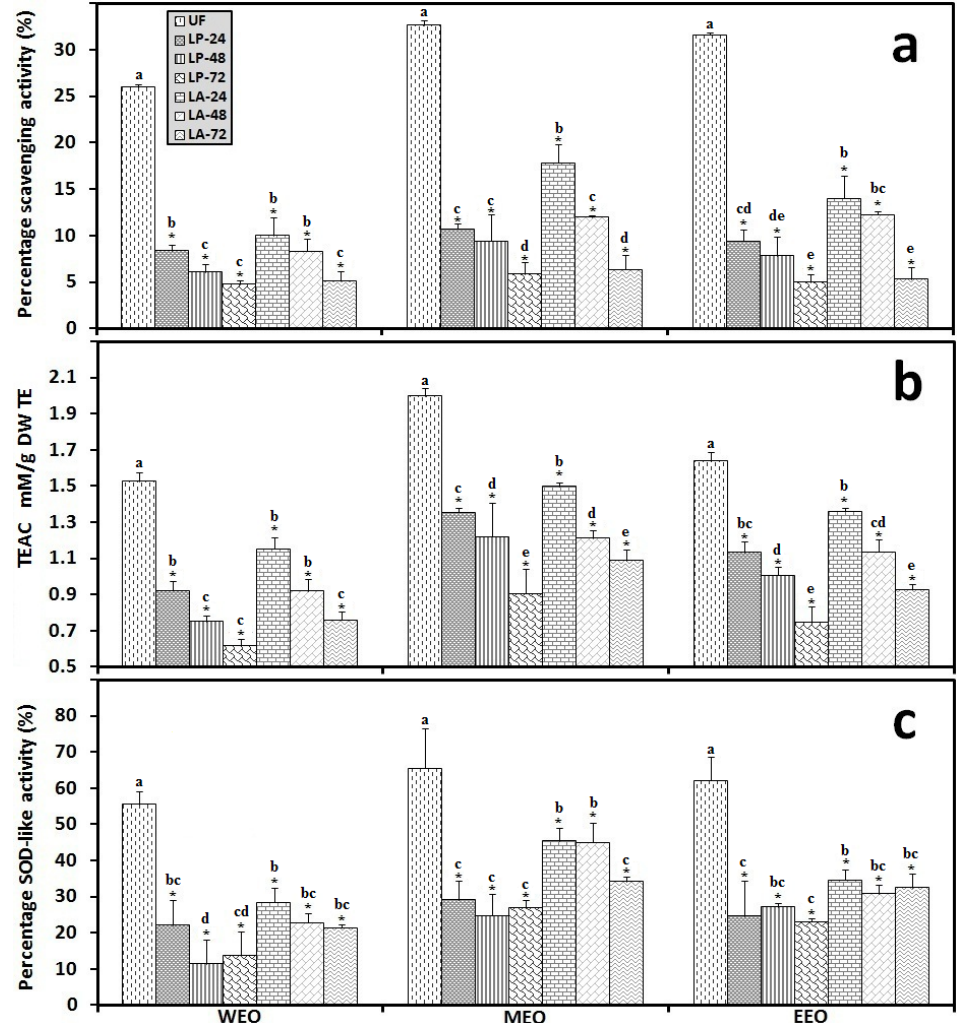
Figure 8. Antioxidant activity of IOSC subjected to LSF using three different